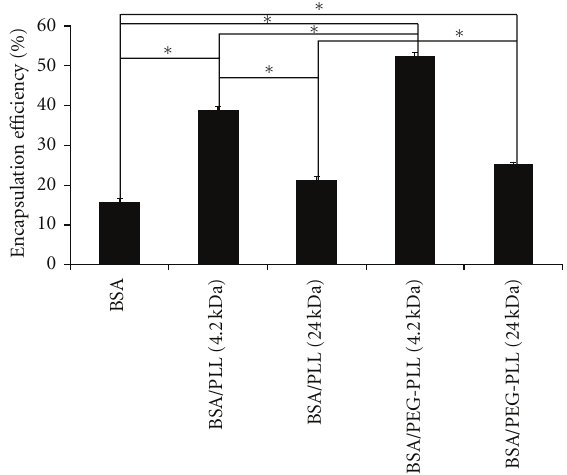
Figure 1: Encapsulation e ffi ciencies of siRNA in various NPs. The value in parentheses represents the molecular weight of the PLL in kDa. For statistical comparison via double-sided t -tests, one asterisk ( ∗ ) represents P < 0 . 05 and data represent average ± 1 SD, n > 5.